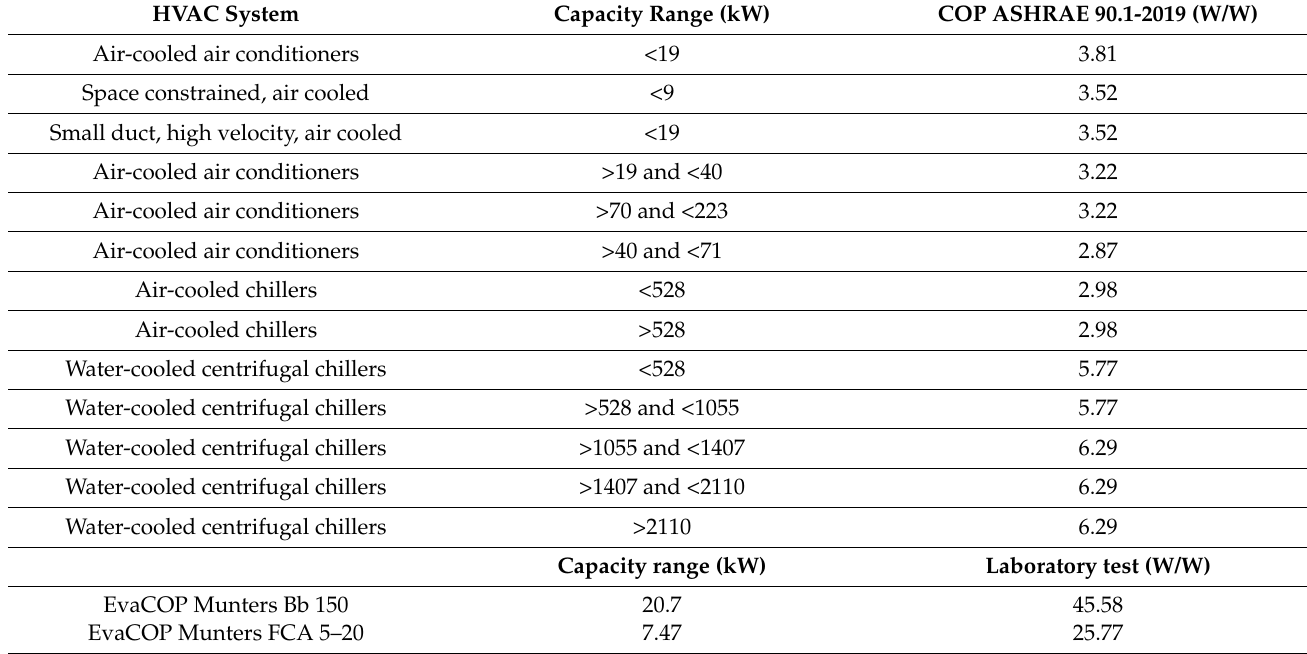
Table 4. Comparison of the ASHRAE 90.1 index with